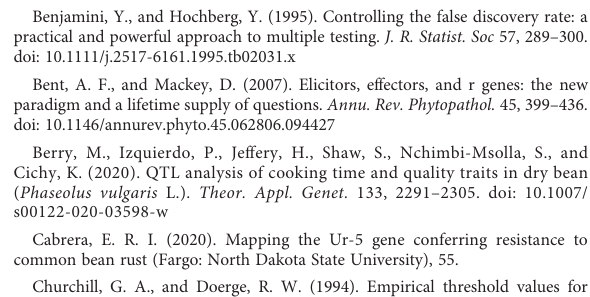
SUPPLEMENTARY FIGURE 1 Seeds of BRSMG Realce, an Andean common bean rajado (striped seed coat) seeded cultivar developed by Embrapa and partners in Brazil (Melo et al., 2014). SUPPLEMENTARY FIGURE 2 Genetic map of the F 2 (BRSMG Realce × BRS FC104) population containing 1,118 SNP markers distributed across all 11 common bean chromosomes